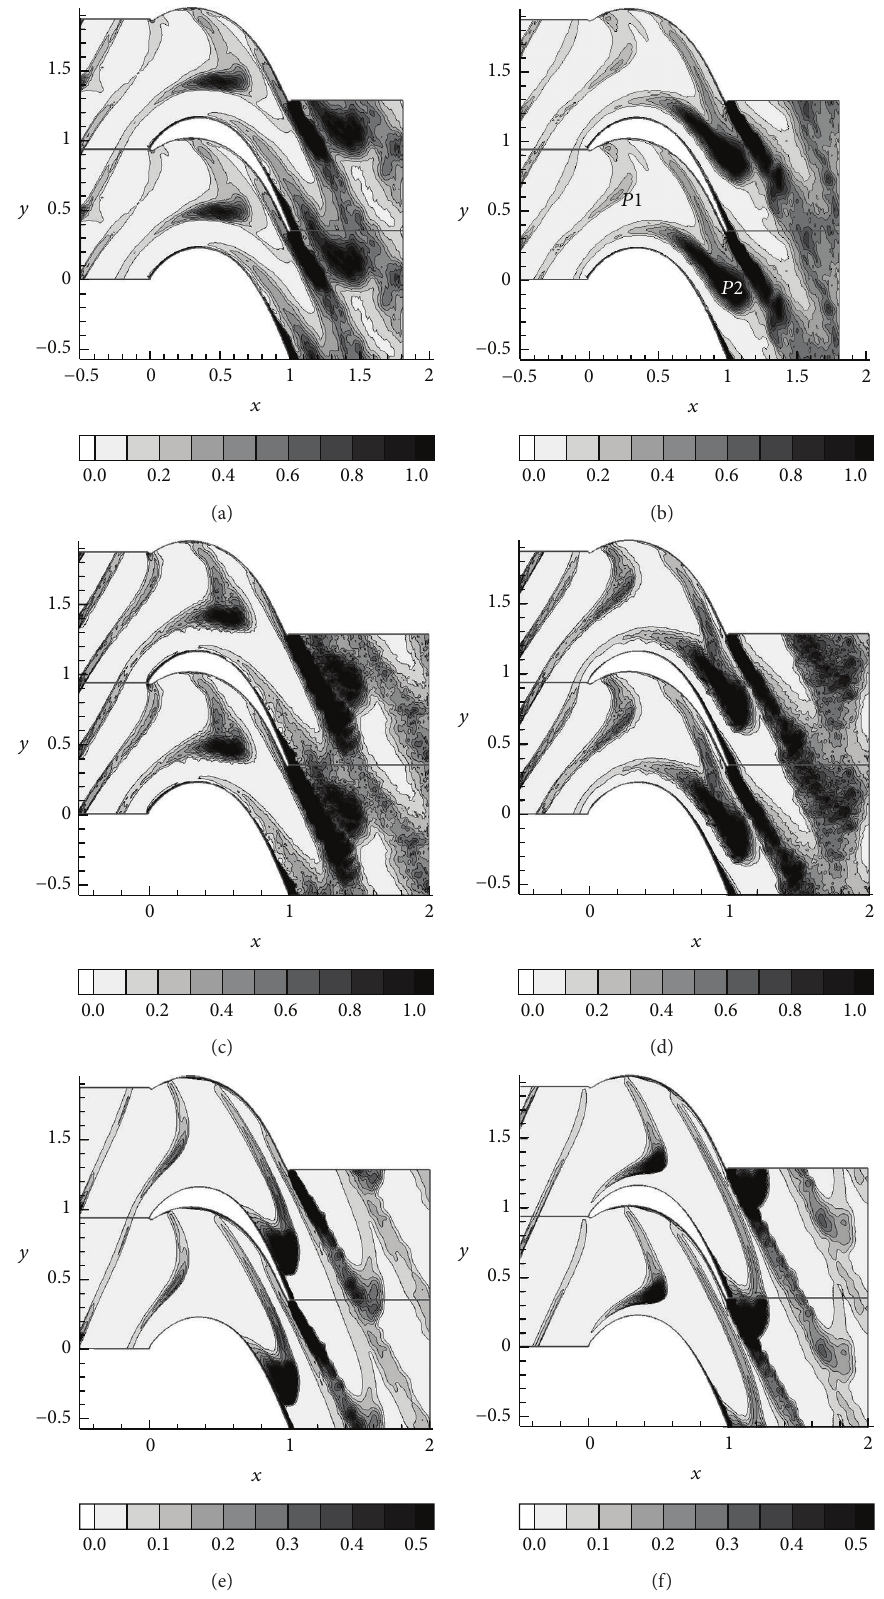
Figure 2: Phase-averaged turbulent kinetic energy: (a) LES: Re = 5.18 × 10 4 , Φ = 0.508 , (b) LES: Re = 5.18 × 10 4 , Φ = 0.008 , (c) DNS: Re = 5.18 × 10 4 , Φ = 0.508 , (d) DNS: Re = 5.18 × 10 4 , Φ = 0.008 , (e) LES: Re = 1.48 × 10 5 , Φ = 0.375 , and (f) LES: Re = 1.48 × 10 5 , Φ = 1.0